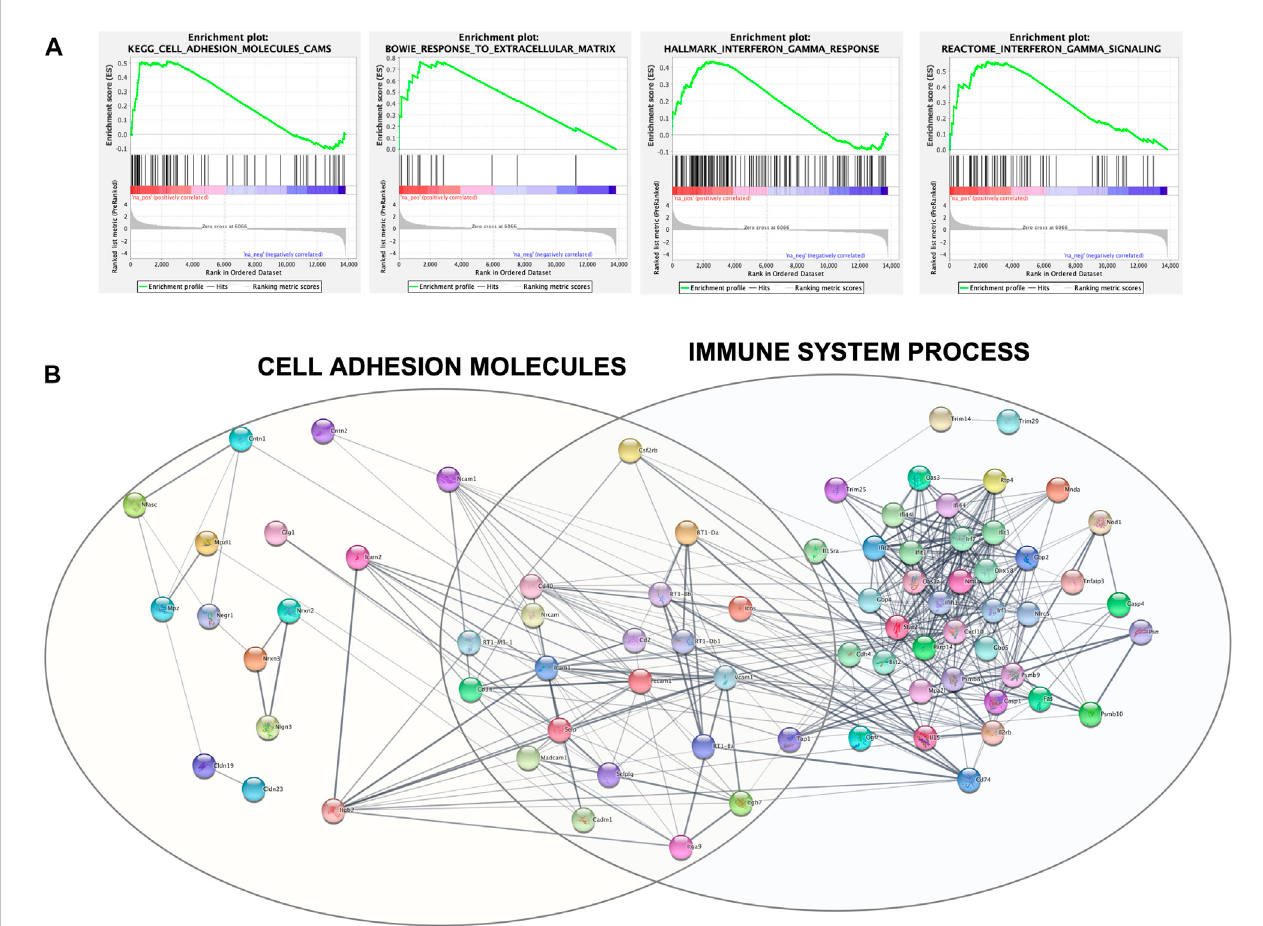
FIGURE 5 (A) GSEA output of the four mainly enriched gene sets. Each vertical black line corresponds to a gene, and its shift to the left indicates its positive enrichment. (B) Protein – protein interaction network built with Cytoscape and clustered with the STRING functional enrichment network plugin.